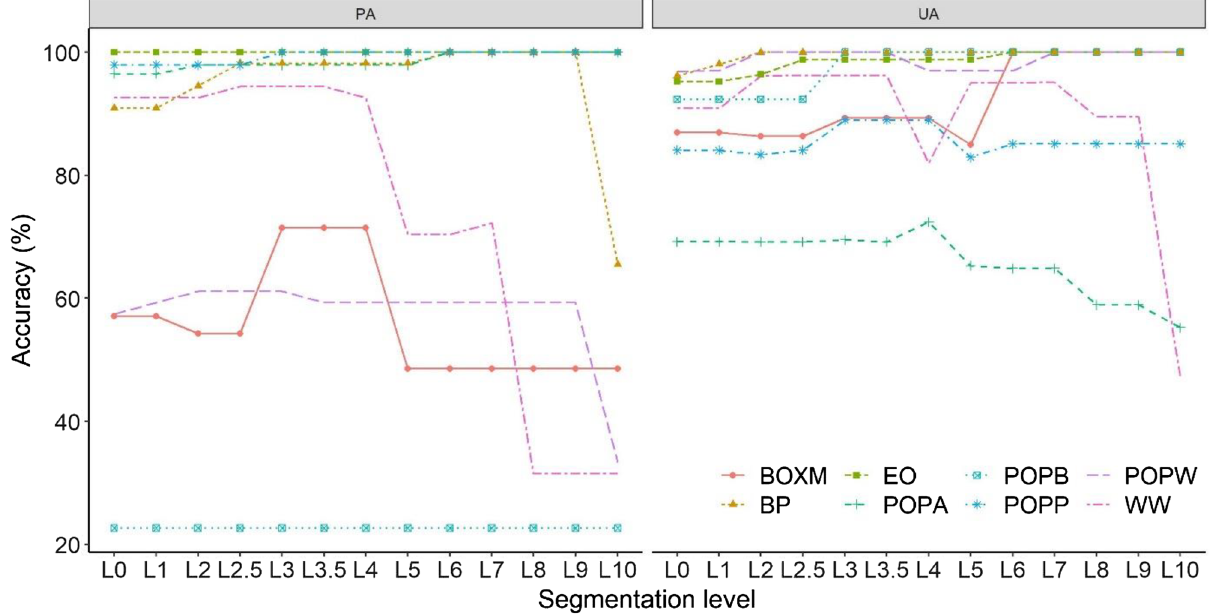
Figure 6. User’s accuracy (UA) and Producer’s Accuracy (PA) of tree species by segment levels. WW White willow, POPA Poplar (Agathe-F), BP Black pine, POPW White poplar, BOXM Boxelder maple, POPP Pannonia poplar, POPB Black poplar, EO English oak.